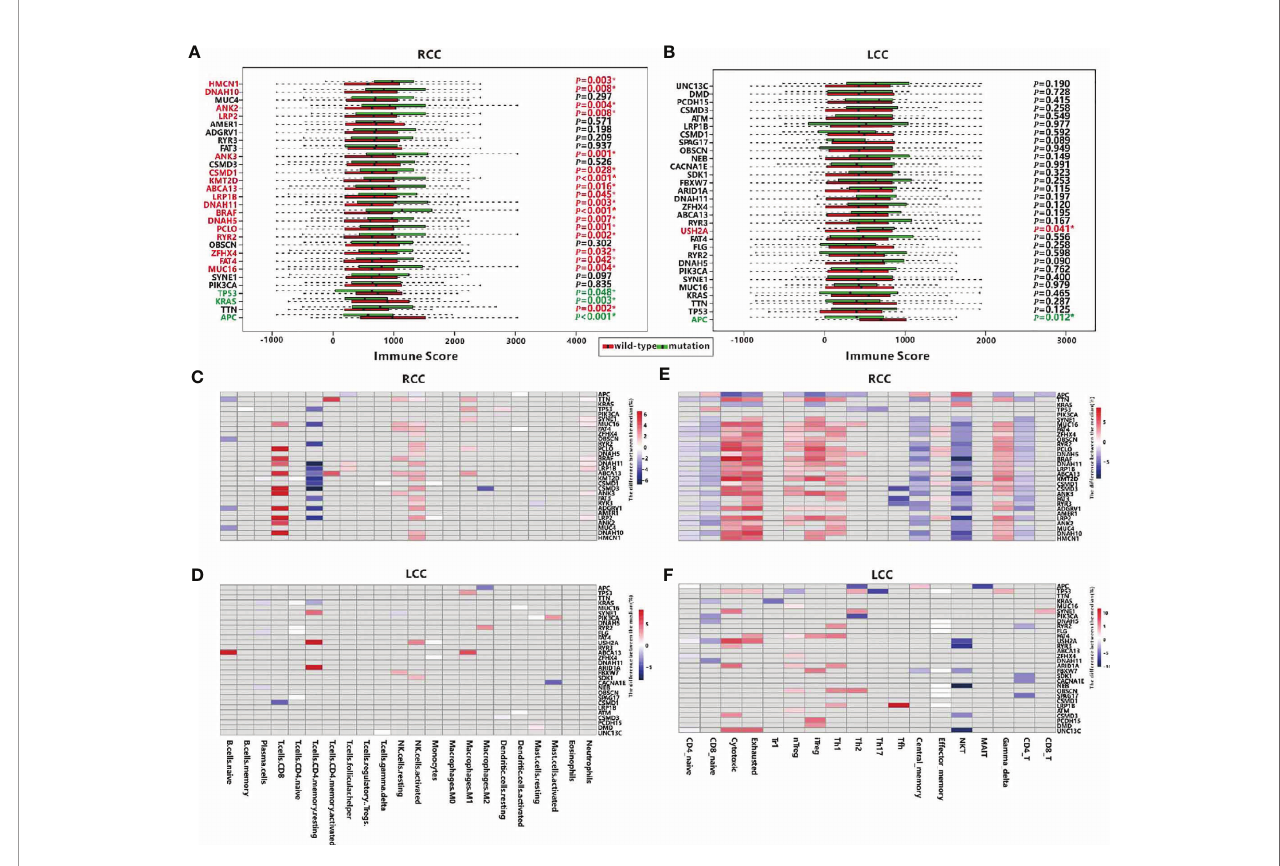
FIGURE 3 | Associations between TMGs and TIME in RCC and LCC. Associations between mutation of TMGs and the immune score in RCC (A) and LCC (B) respectively. TMGs marked in red are associated with a higher immune score when they are mutated while TMGs marked in green have the opposite effect. Associations between TMGs and 22 immune cells using the Wilcoxon test in RCC (C) and LCC (D) . Associations between TMGs and 18 T cells using the Wilcoxon test in RCC (E) and LCC (F) . The grey cells represent insigni fi cant associations while the colored cells represent signi fi cant associations with p <0.05. The red color represents a higher immune cell fraction in mutation group while the blue color represents a lower immune cell